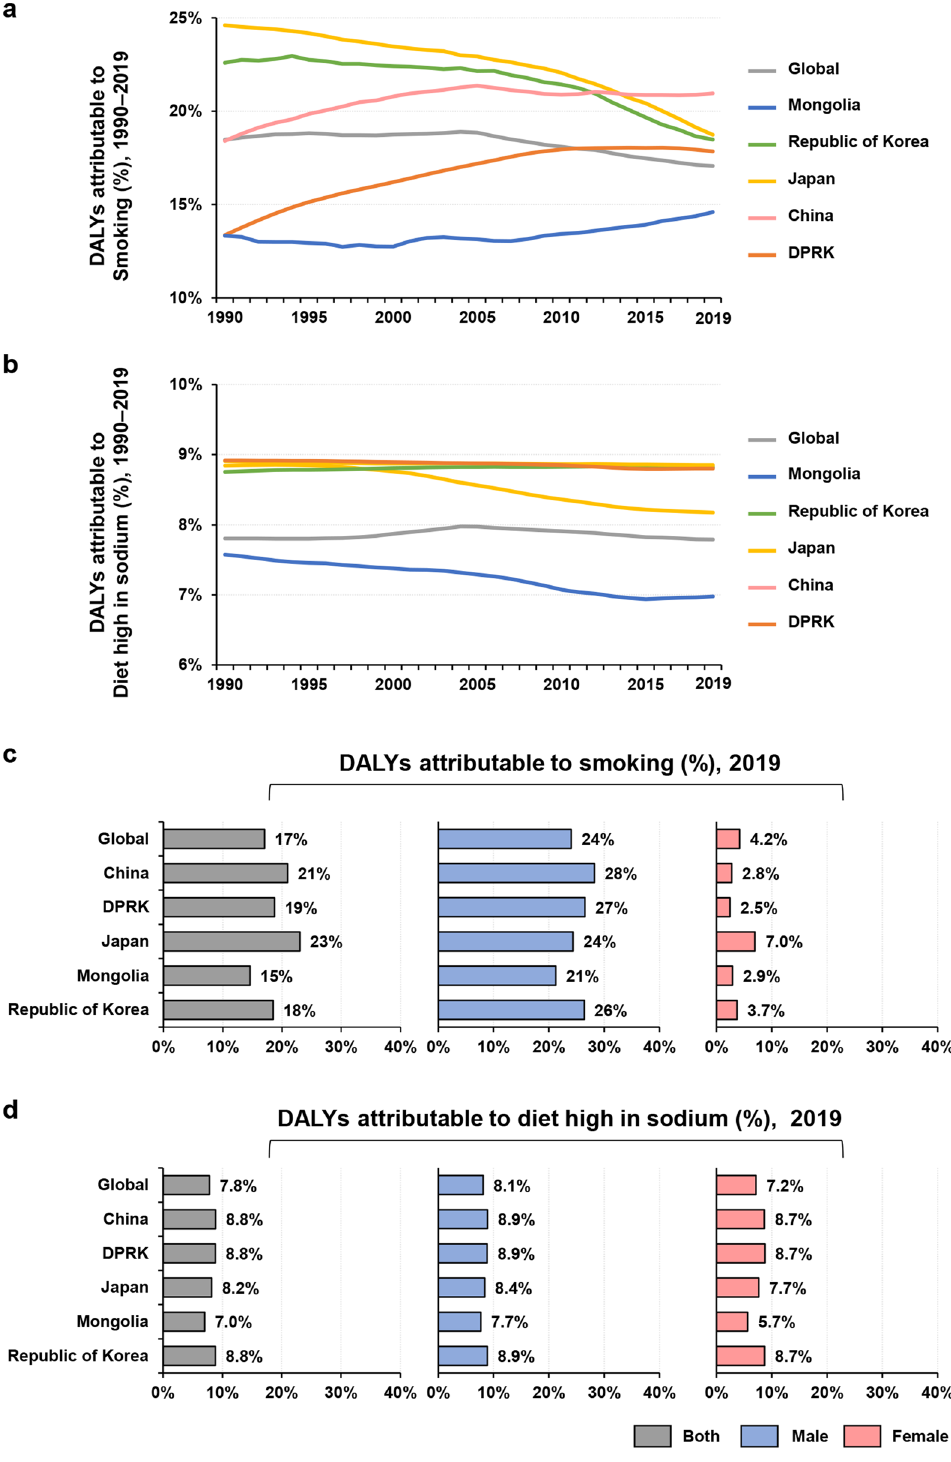
Figure 6. Trends of gastric cancer age-standardized DALYs attributable to smoking ( a ) and a high-sodium diet ( b ) from 1990 to 2019 according to sex. Proportions of age-standardized DALYs of gastric cancer attributable to smoking ( c ) and a high-sodium diet ( d ) worldwide and in five Asian countries in 2019. DALYs, disability- adjusted life-years. DPRK, the Democratic People’s Republic of